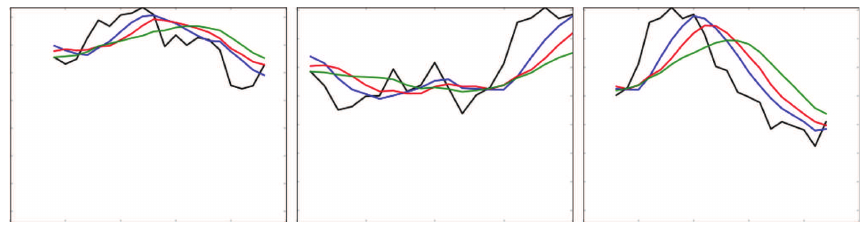
Figure 19: Experiment 1 with Label − 1.